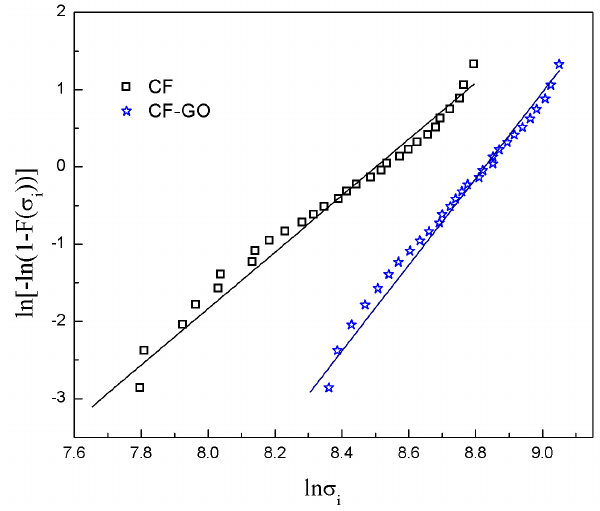
Figure 7. Weibull plots for tensile strength of the CF and CF–GO by monofilament.